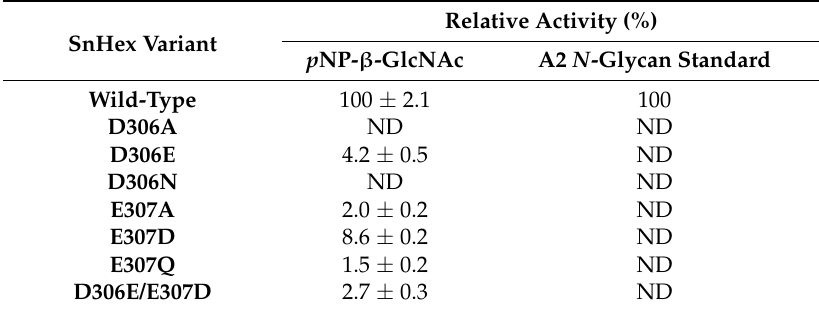
Table 2. Activity of wild-type and mutant variants of SnHex using p NP- β -GlcNAc and the A2 N -glycan standard as substrates. ND: no detection of any SnHex enzyme